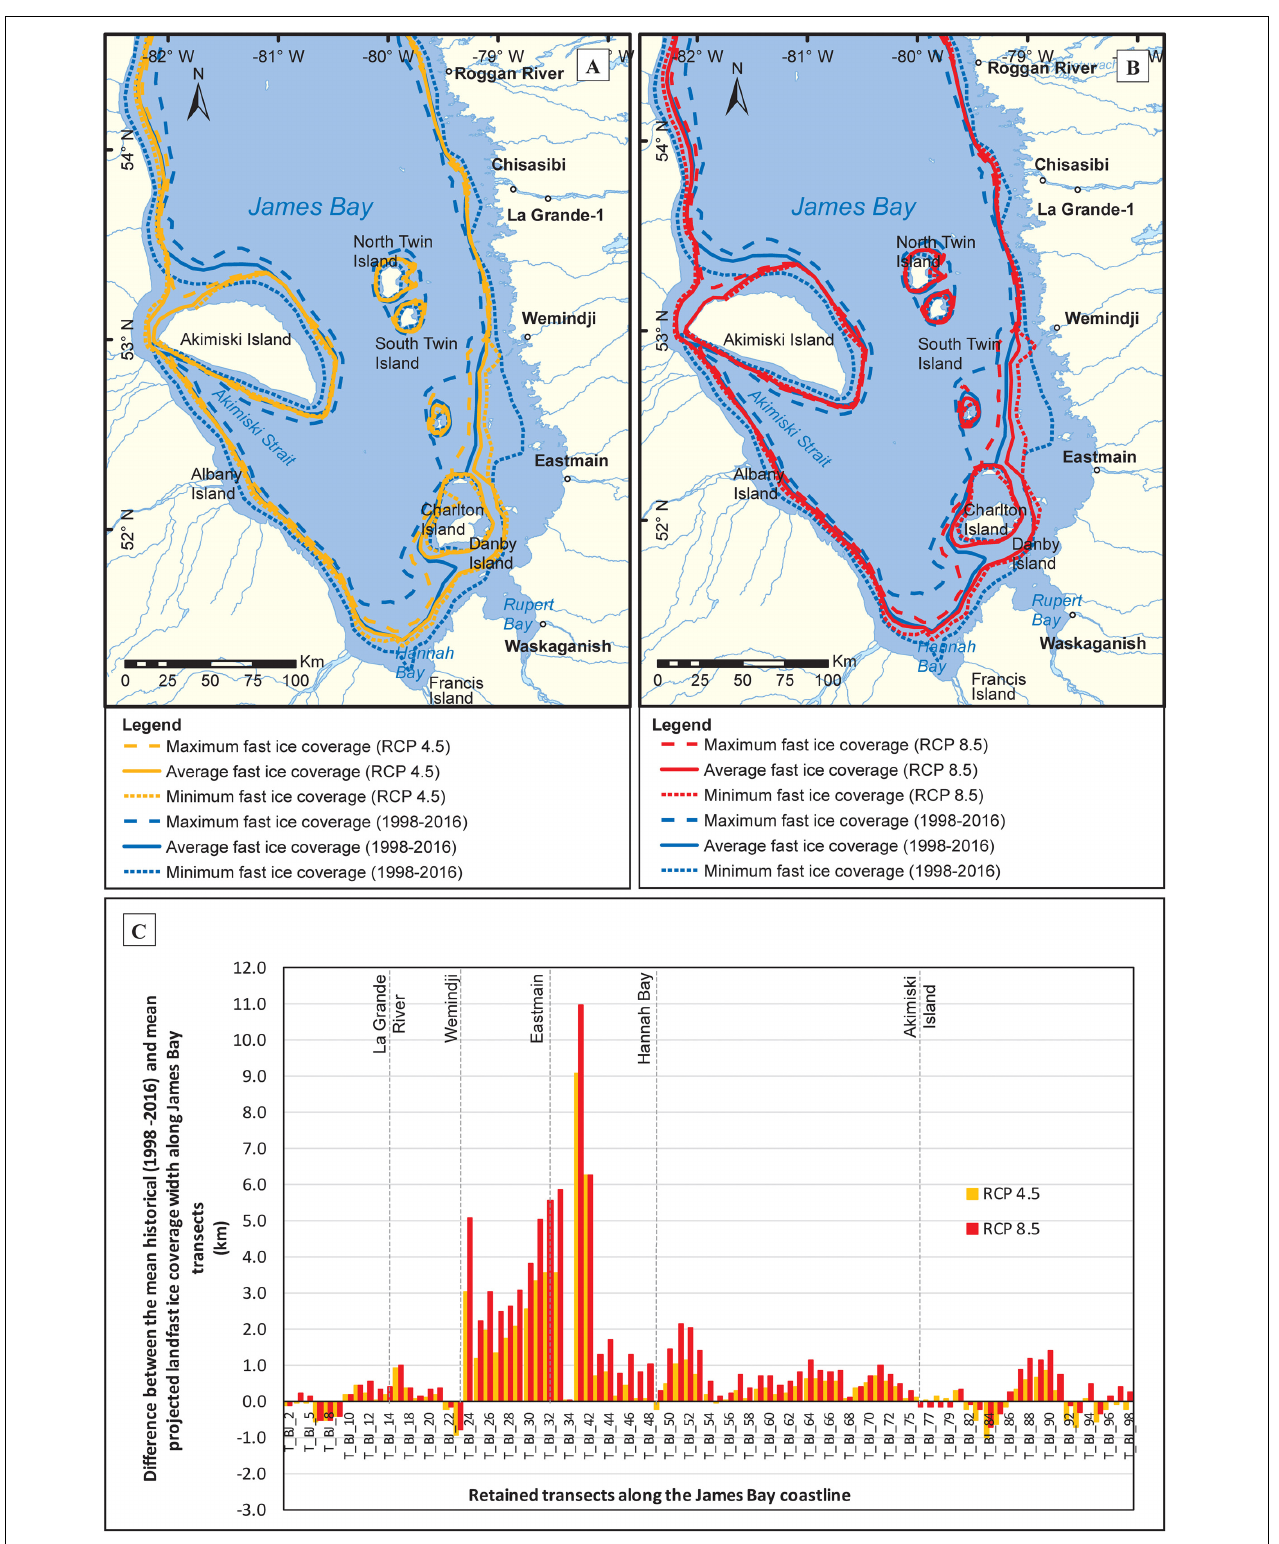
FIGURE 11 | Comparison of the landfast ice extent in James Bay for the 2040–2060 period under climatic scenarios RCP4.5 (A) and RCP8.5 (B) with the extents of the 1998–2016 period. Computation of the difference between the mean historical (1998–2016) and mean projected landfast ice coverage width along James Bay transects (C)